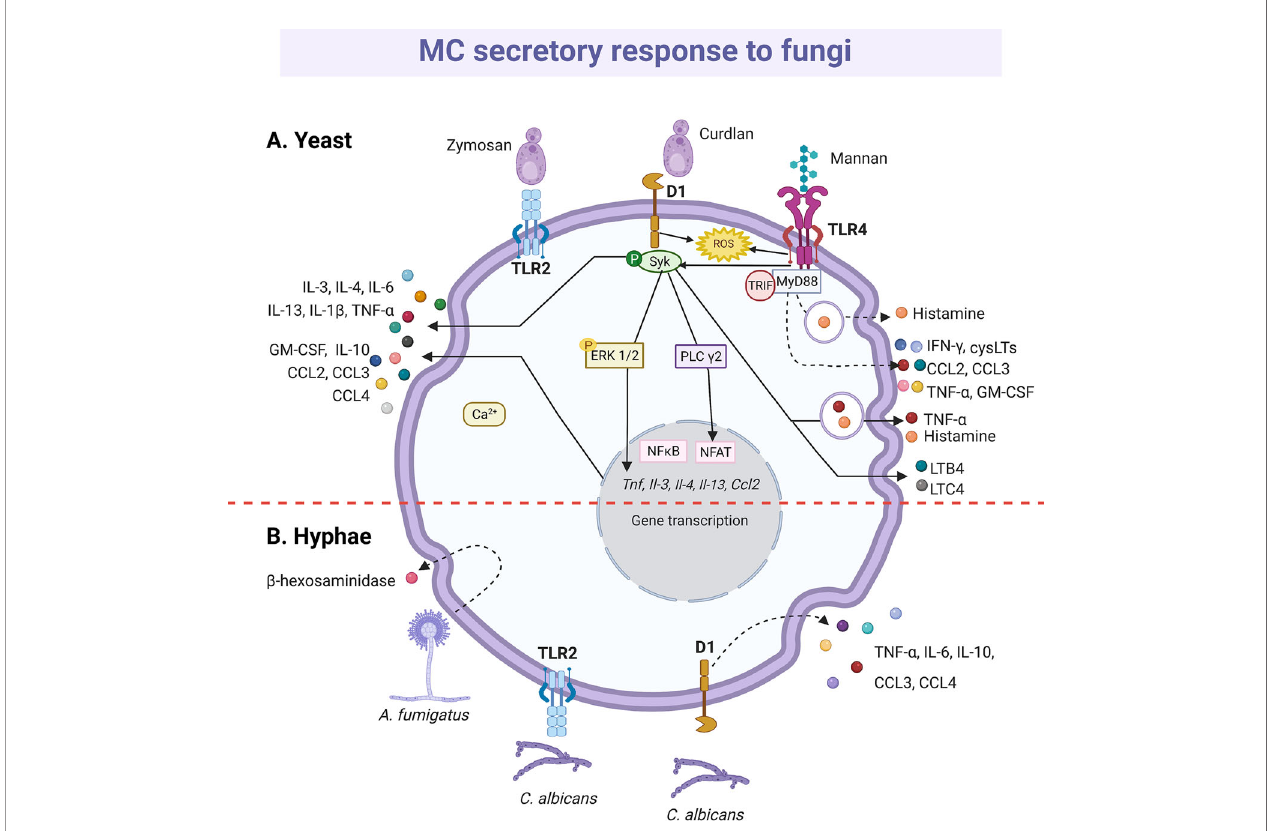
FIGURE 7 | MC-released mediators and signaling pathways in response to fungi. (A) Toll-like receptor (TLR)-2 and Dectin-1 (D1) receptors recognize yeasts. Triggering of D1 receptor leads to Syk kinase activation and the release of histamine and cytokines, such as tumor necrosis factor (TNF)- a , interleukin (IL)-1 b , IL-3, IL-4, IL-6, IL-10, IL-13 chemokines such as CCL2, CCL3 and CCL4 and granulocyte and monocyte colony stimulating factor (GM-CSF). Secretion of leukotriene (LT) B4 and LTC4 also has been described, together with the reactive oxygen species (ROS)-dependent activation of NF k B. Mannan recognition through TLR4 receptor induces histamine release and ROS, cysLTs, cytokine and chemokine production in a MyD88-, TRIF- and Syk-dependent manner. (B) Hyphae also seem to be recognized by TLR2 and D1 receptors that leads to cytokine secretion. Finally, Aspergilius fumigatus induces the release of b -hexosaminidase. Dashed-lines show unknown pathways activated in MC response to yeast and hyphae. Solid-lines show fragments of signaling pathways that have been experimentally demonstrated and dashed-lines show reported effects of receptor triggering or MC-fungi interactions. Central red dashed-line separate what is known about the interactions with the yeasts or hyphae of